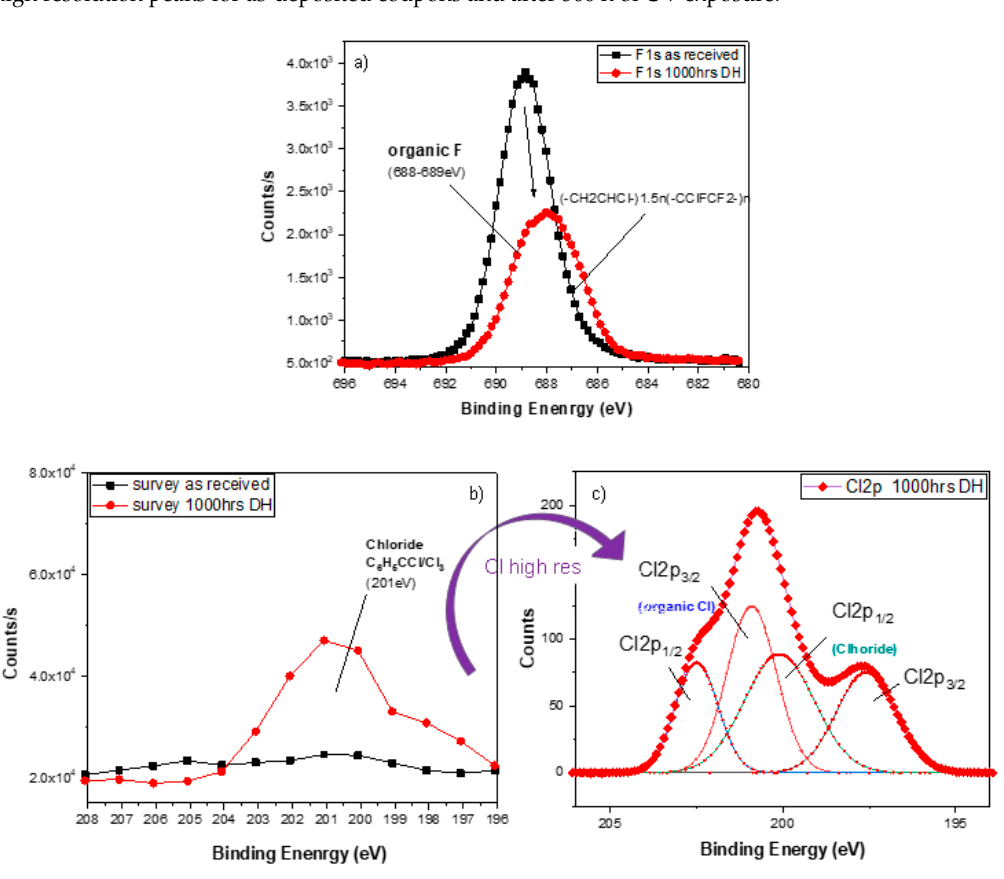
Figure 4. ( a ) XPS high resolution F1s peak before and after 1000 h of DH exposure; ( b ) zoomed-in XPS spectrum detecting the presence of chlorine after 1000 h of DH exposure and ( c ) high-resolution Cl2p peak with the appearance of chlorine likely due to contamination. (Coatings B).